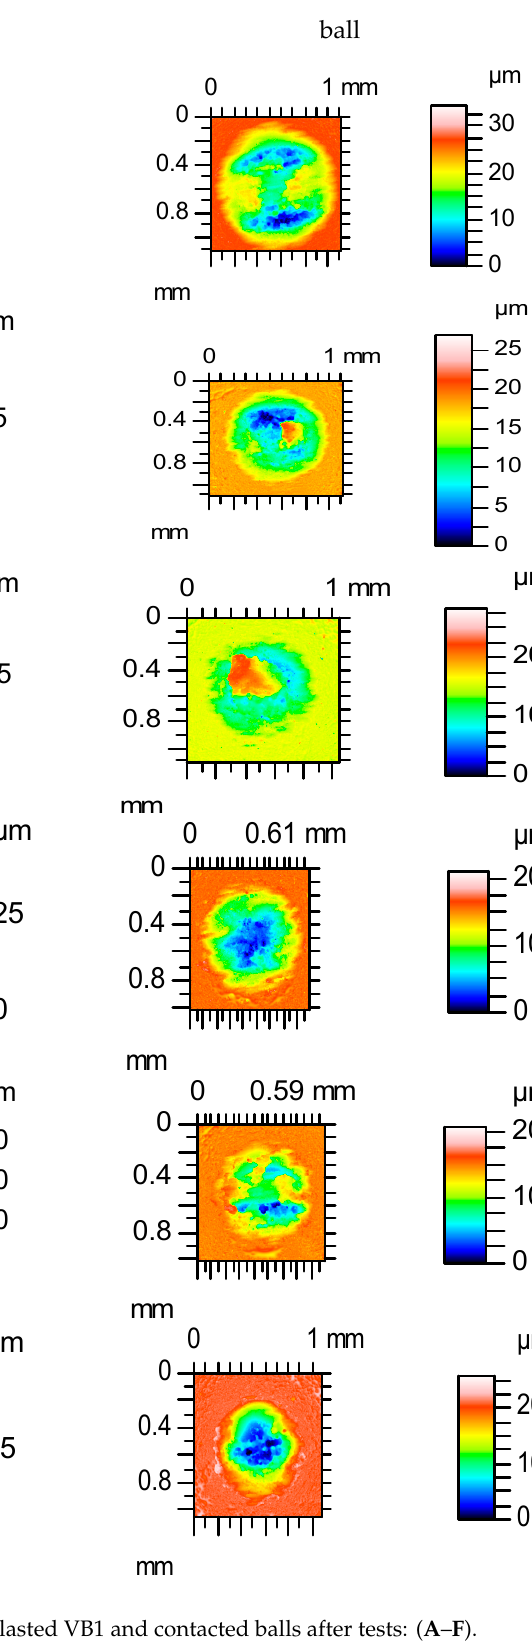
Figure 9. Contour maps of disc vapour-blasted VB1 and contacted balls after tests: ( A – F ).